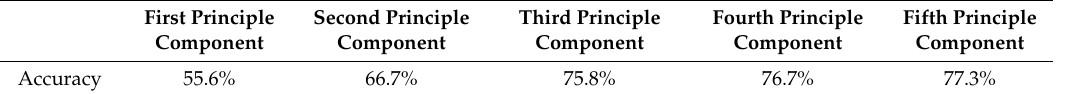
Table 7. Results of different components for SVM